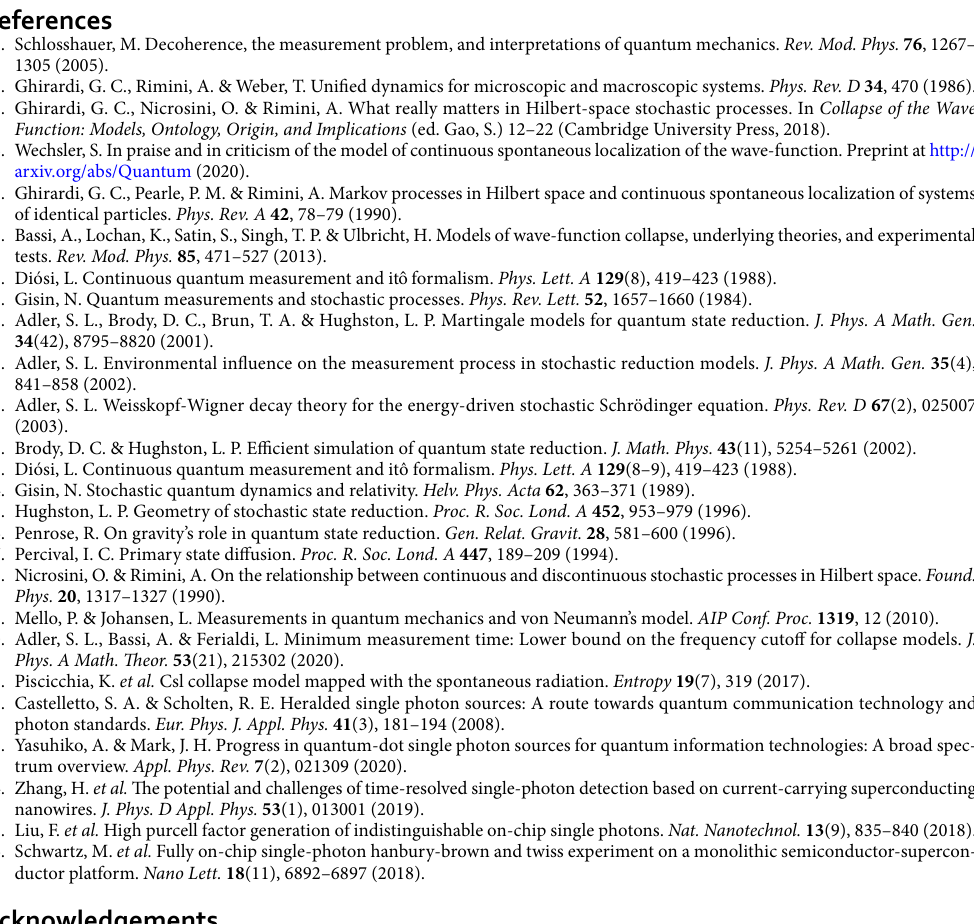
2 = 1 . The blue and green curves correspond to the starting conditions c R | |